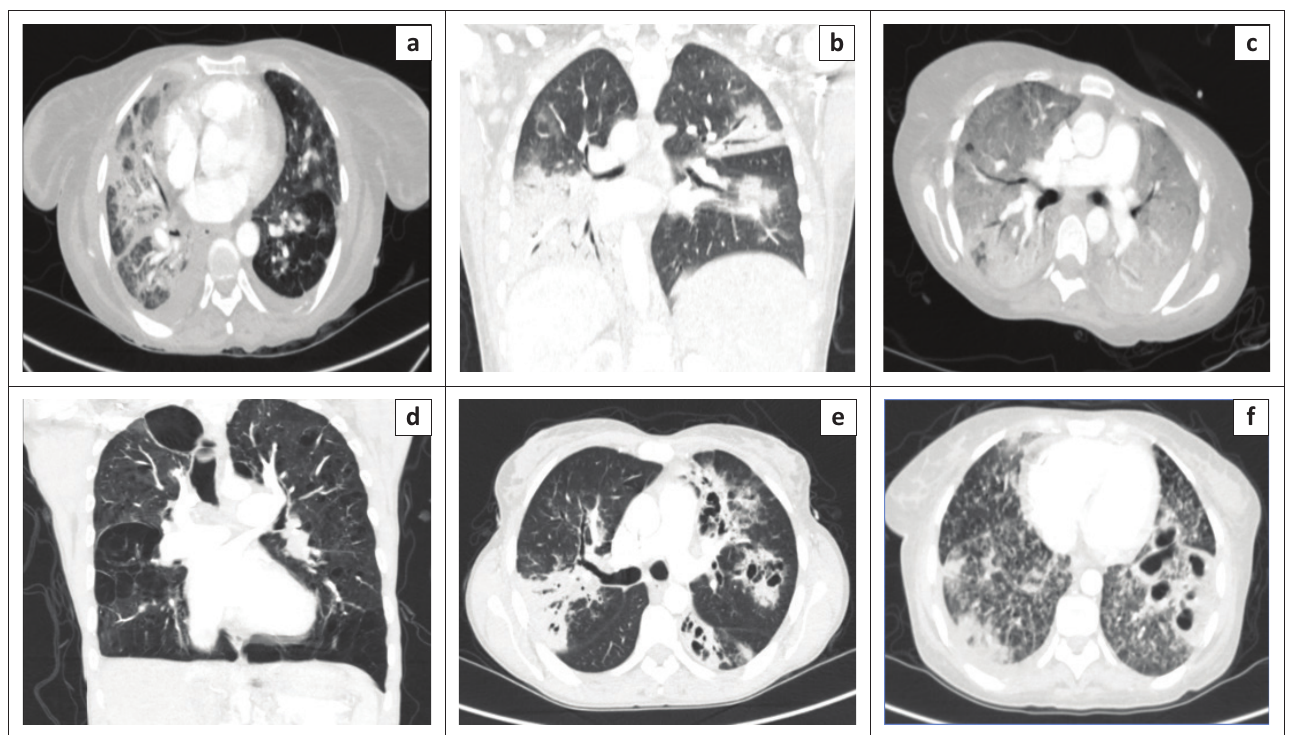
FIGURE 2 : Axial (a, c, e, f) and coronal (b, d) CT slices of incidental parenchymal findings in patients without pulmonary embolism. (a–c) Extensive consolidations in three different patients, (d) diffuse emphysema, (e) cavitary multi-lobar pneumonia, and (f) left lower lobe lung cavitation with bilateral background tree-in-bud nodules in a patient with pulmonary